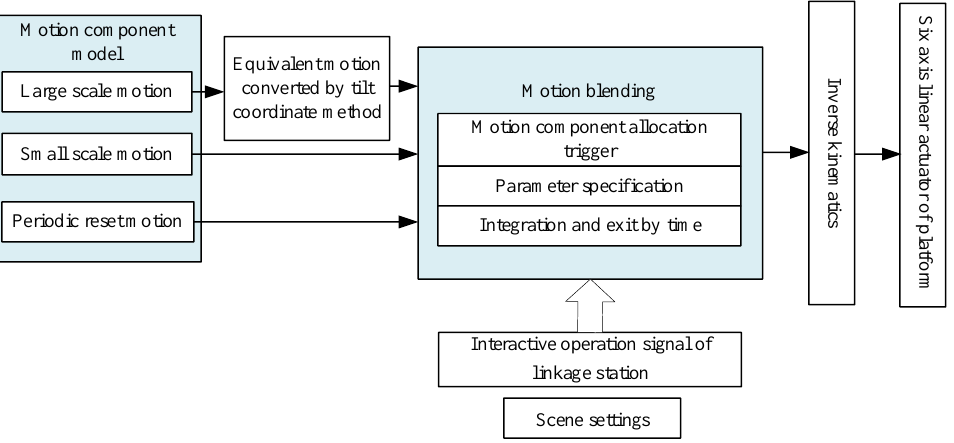
Figure 7. Motion simulation of crane based on streamlined motion blending technology.